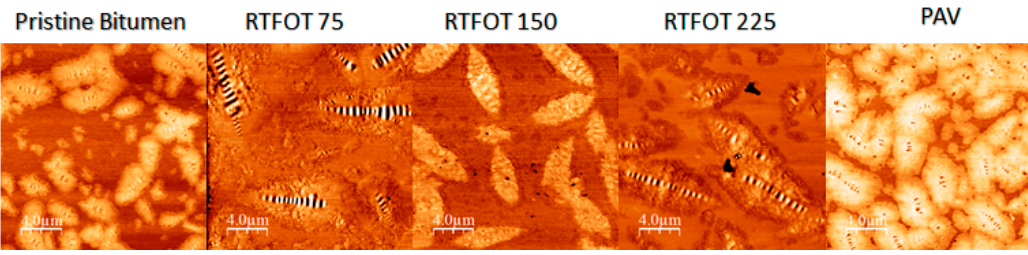
Figure 7. AFM phase images of PB, BRTFOT-75, BRTFOT-150, BRTFOT-225, and BPAV.